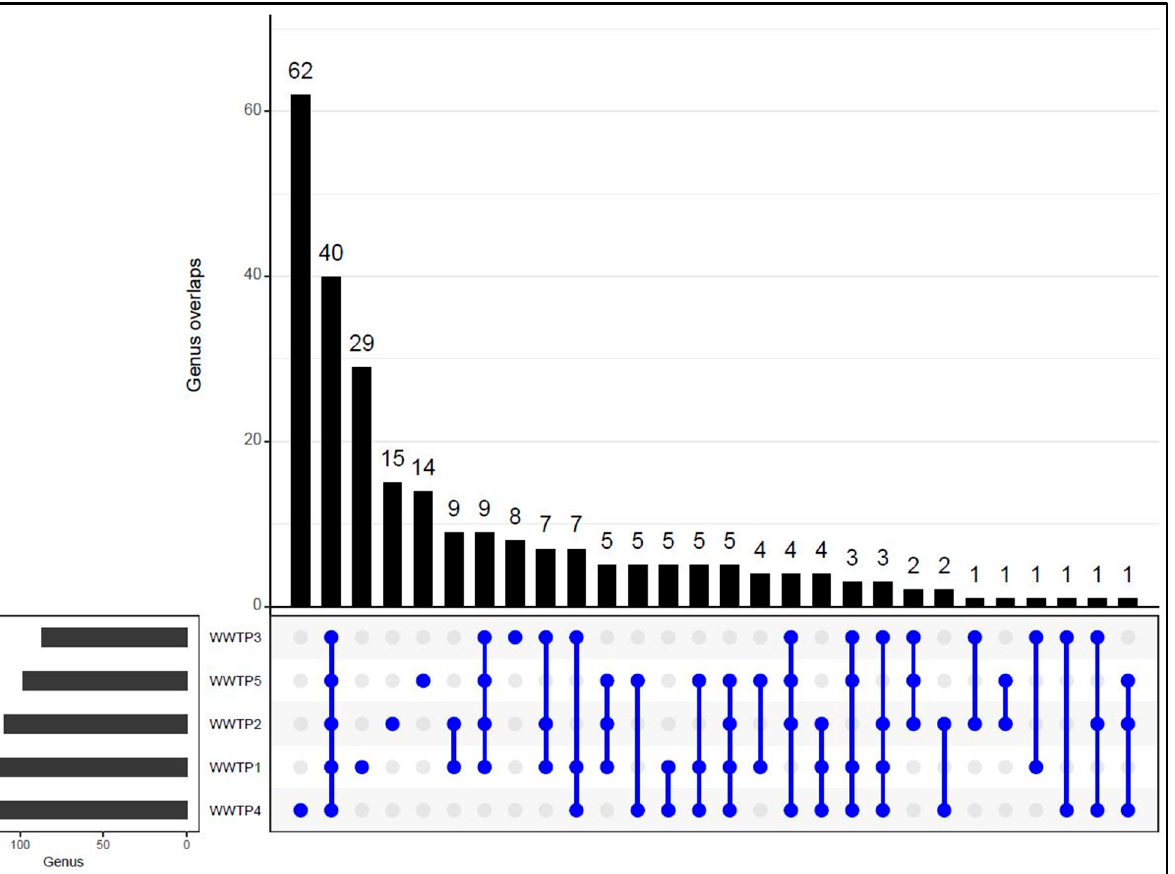
Figure 5. UpSet plot showing shared and distinct bacterial genera in influent wastewater from five WWTPs. Numbers above the bars indicate the number of overlapping genera between different WWTPs appearing in the left panel display.